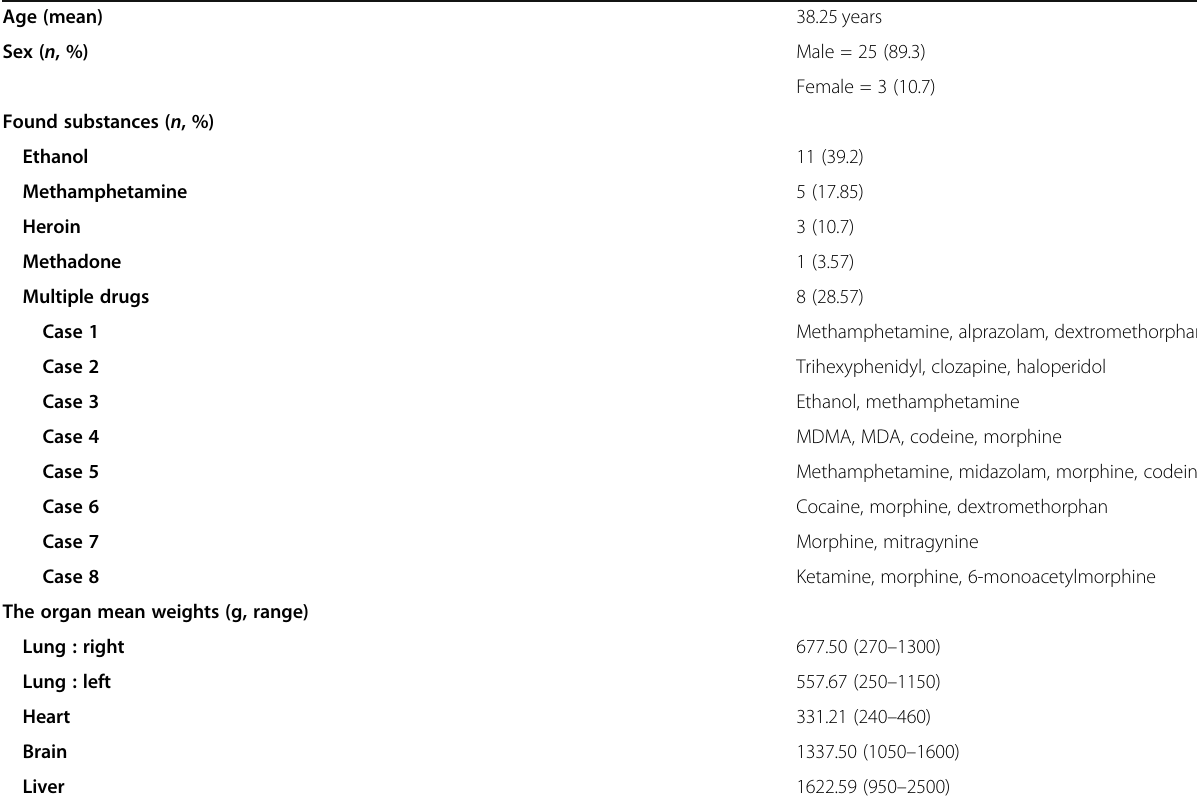
Table 3 The demographic data in the study